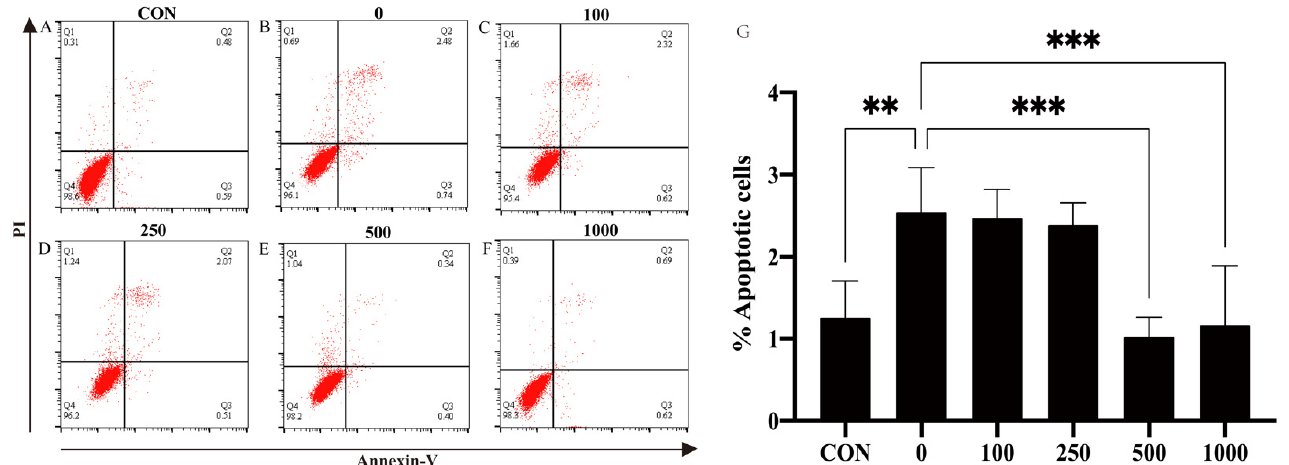
Figure 2. Effects of MT treatment on H 2 O 2 -induced apoptosis in PTr2 cells. The PTr2 cells were treated with medium as control (A) and MT at the concentrations of 0 (B), 100 (C), 250 (D), 500 (E), and 1000 (F) for 24 h and then exposed to H 2 O 2 for 4 h. (G) Histograms showed that distribution of apoptotic cells after different treatment. The data are expressed as the means ± SEM from at least 6 separate experiments. p < 0.05 was considered to be statistically significant. p > 0.05 (ns), p < 0.01 (**), p < 0.0001 (***).